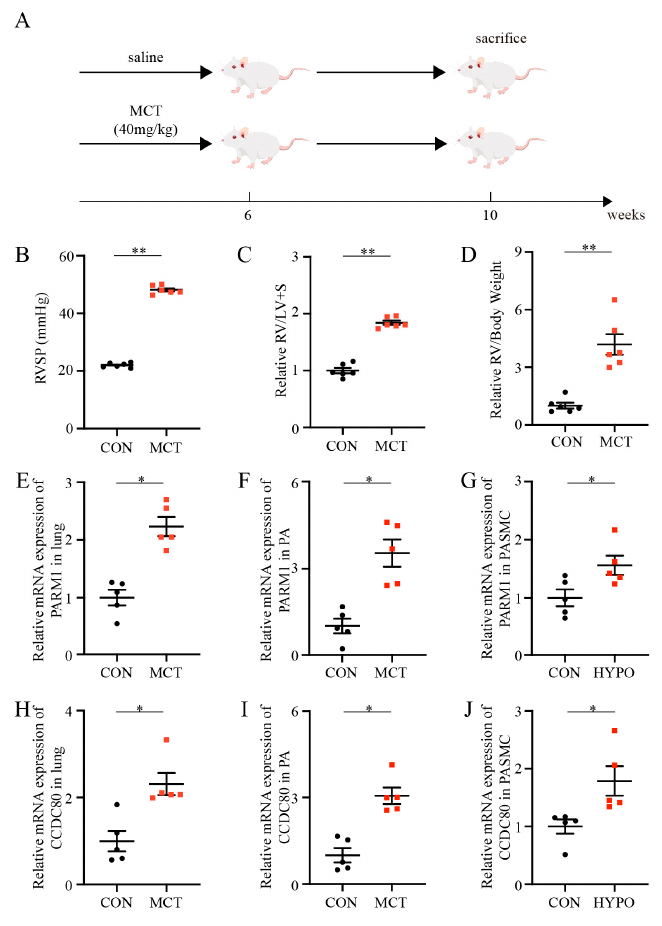
Figure 4. Establishment of pulmonary arterial hypertension rat model and hub gene validation. ( A ) Schematic illustration of pulmonary arterial hypertension rat model. ( B – D ) RVSP, RV/(LV + S), and RV/body weight at 4 weeks after MCT injection (n = 6 each). ( E – J ) Relative mRNA expression of PARM1 and CCDC80 normalized to a β -actin internal control (n = 5 each). Data are shown as mean ± SEM. * p < 0.05, ** p < 0.01 vs. CON group (student’s t -test). CON, control rats without pulmonary arterial hypertension; PAH, pulmonary arterial hypertension; MCT, monocrotaline; RVSP, right ventricle systolic pressure; RV, right ventricle; LV, left ventricle. S, septum.